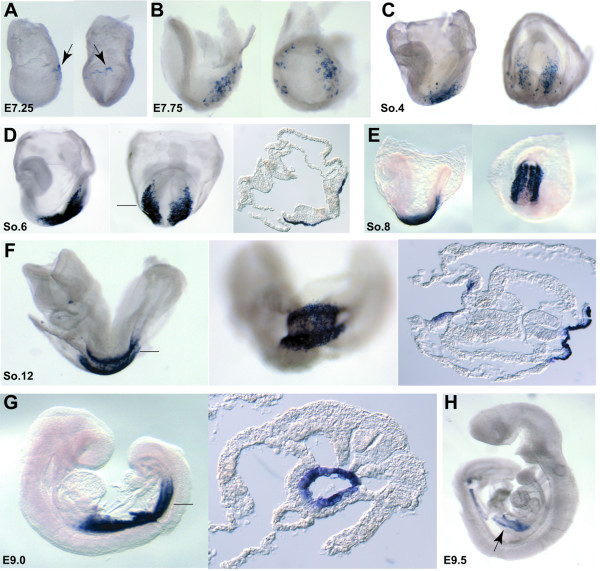
Expression of 5730521E12Rik in the early developing mouse embryo. 5730521E12Rik expression from E6.5 to E9.5 in the mouse embryo was examined by whole mount in situ hybridization. The embryos at each represented stage are shown in lateral and posterior view (A-D) or lateral and ventral view (E, F), except E9 and E9.5 (G, H). For the lateral view, the embryos are oriented so that the anterior is to left. The expression of 5730521E12Rik is dynamic. Hybridization signals initiate at E7.25 in a few cells in the posterior of the embryos (arrowheads in A), then is continuously detected in broader bilateral domains of the middle-posterior of the embryos at head fold (B) and early somite (C-E) stages. At E8.5–E9 (E-G), 5730521E12Rik expression level reaches the highest in the midgut. At E9.5, the signal is retained but is down-regulated (H).